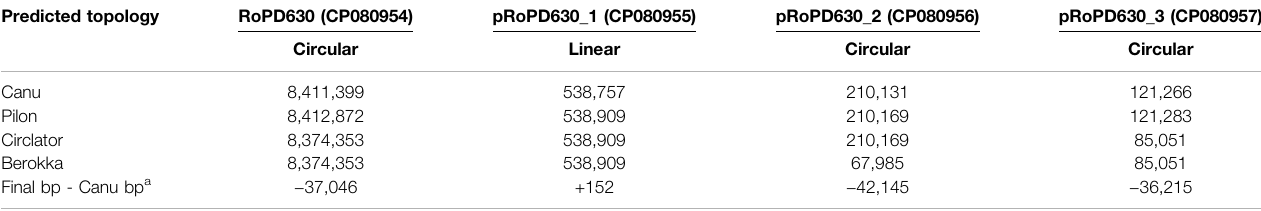
TABLE 1 | Length (bp) of chromosome and plasmids throughout the correction and circularization steps. Predicted topology